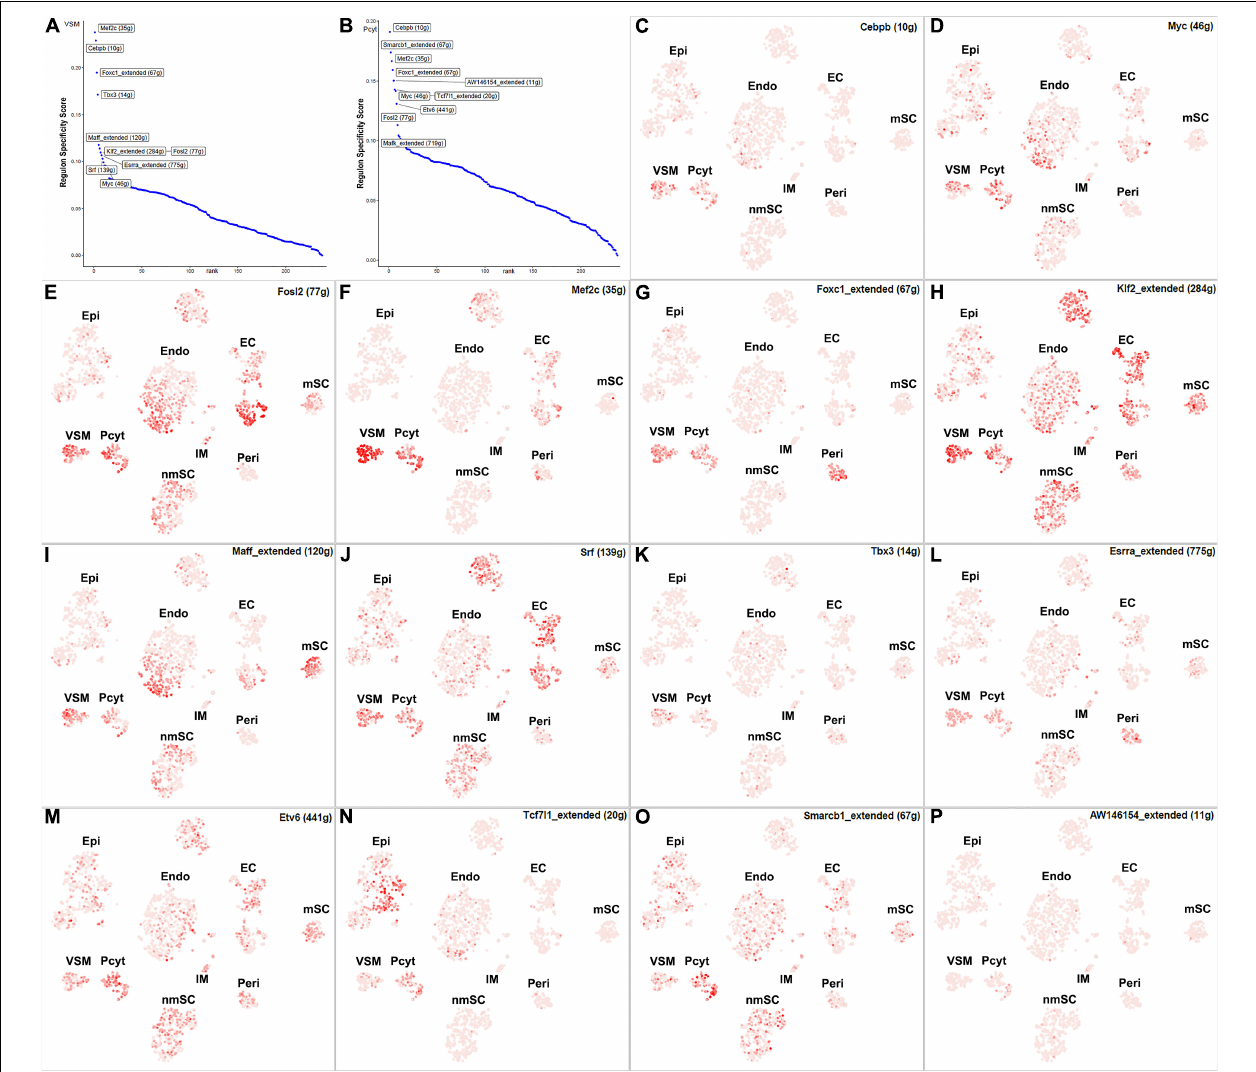
FIGURE 10 | TF activity in VSM cells and pericytes. (A) Regulon-specificity score in VSM cells with top 10 specific TFs labeled. (B) Regulon-specificity score in pericytes with top 10 specific TFs labeled. (C–P) The tSNE showing regulon activity for Cebpb, Myc, Fosl2, Mef2c, Foxc1, Klf2, Maff, Srf, Tbx3, Esrra, Etv6, Tcf7l1, Smarcb1, and AW146154 in VSM cells and